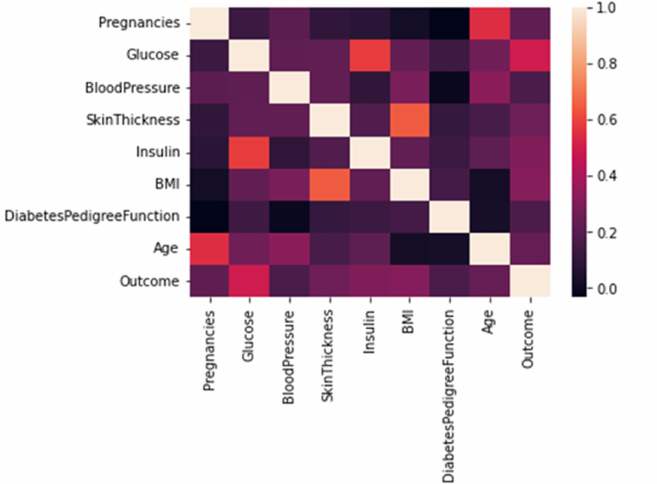
Figure 6. Data visualization using